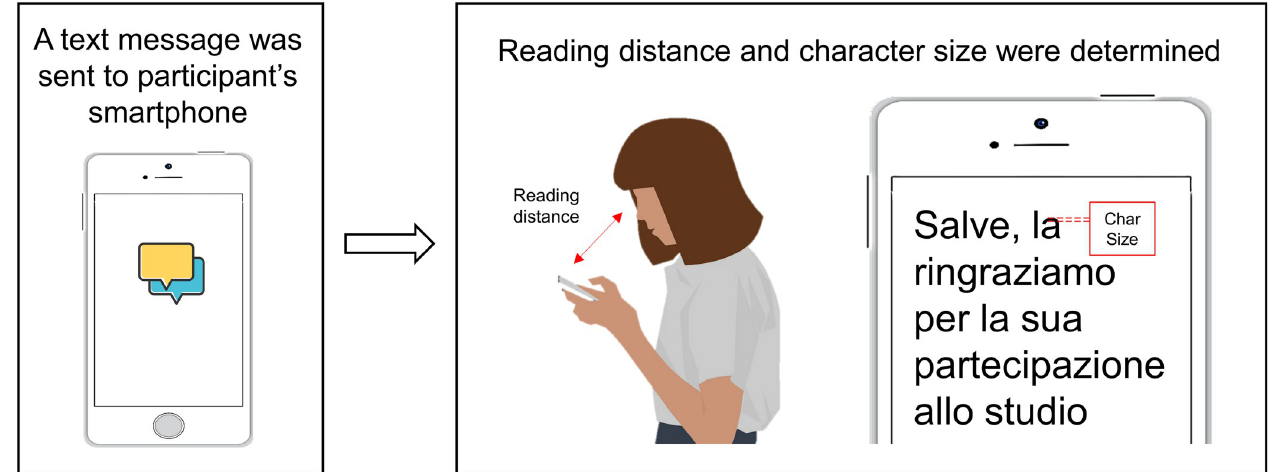
Fig 1. Experimental procedure. Participants received a text message and were instructed to read it. Reading distance and character size were obtained.